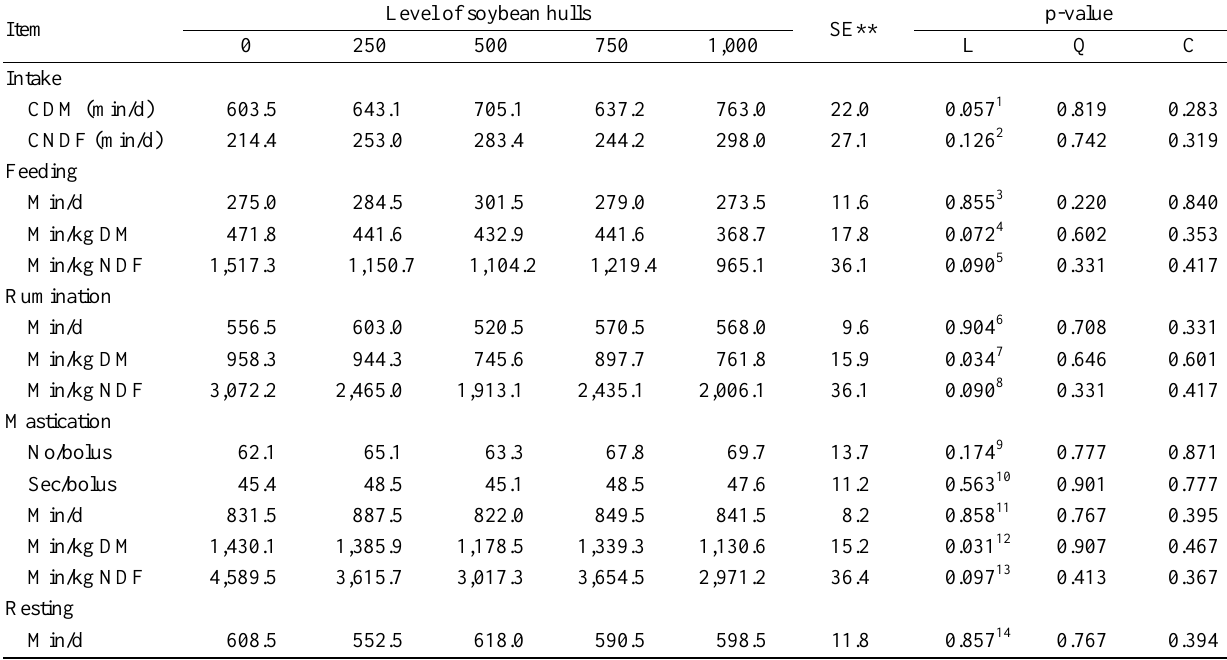
Table 3. Intake of dry matter (CDM) and neutral detergent fiber (CNDF) in 24 h and time spent feeding, ruminating, masticating, and resting by lambs fed diets containing different levels of soybean hulls as a substitute for